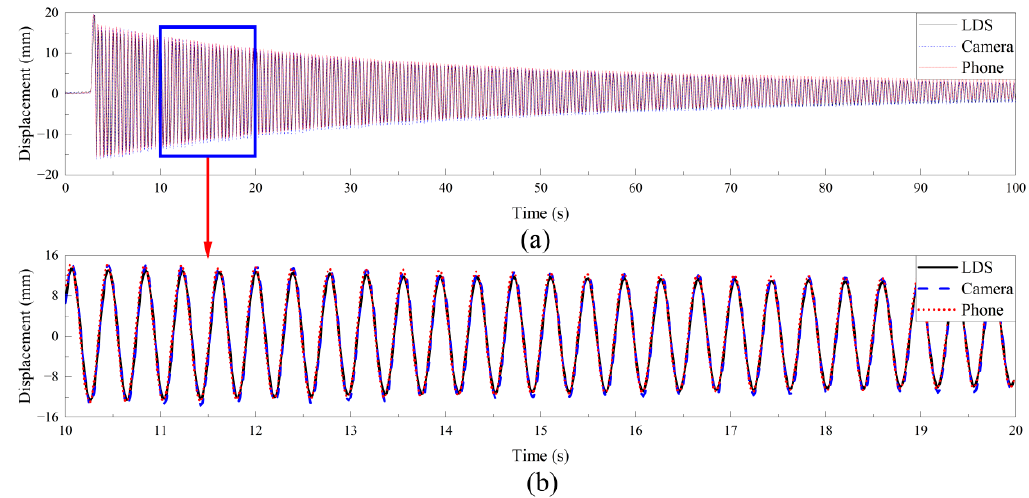
Figure 9. Time history comparison of smartphone displacement monitoring through frame rate correction: ( a ) Whole displacement time history; ( b ) 10~20 s displacement time history.